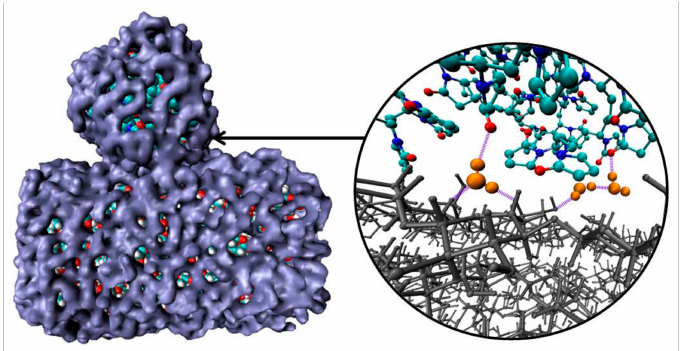
Figure 8. Snapshots of solvation shells (blue) of PVP and cellulose; hydrogen bonds (violet) forming by water molecules (orange) with PVP and cellulose (gray). Other water molecules have been deleted for clarity to highlight the polymer and the cellulose fragment interactions.